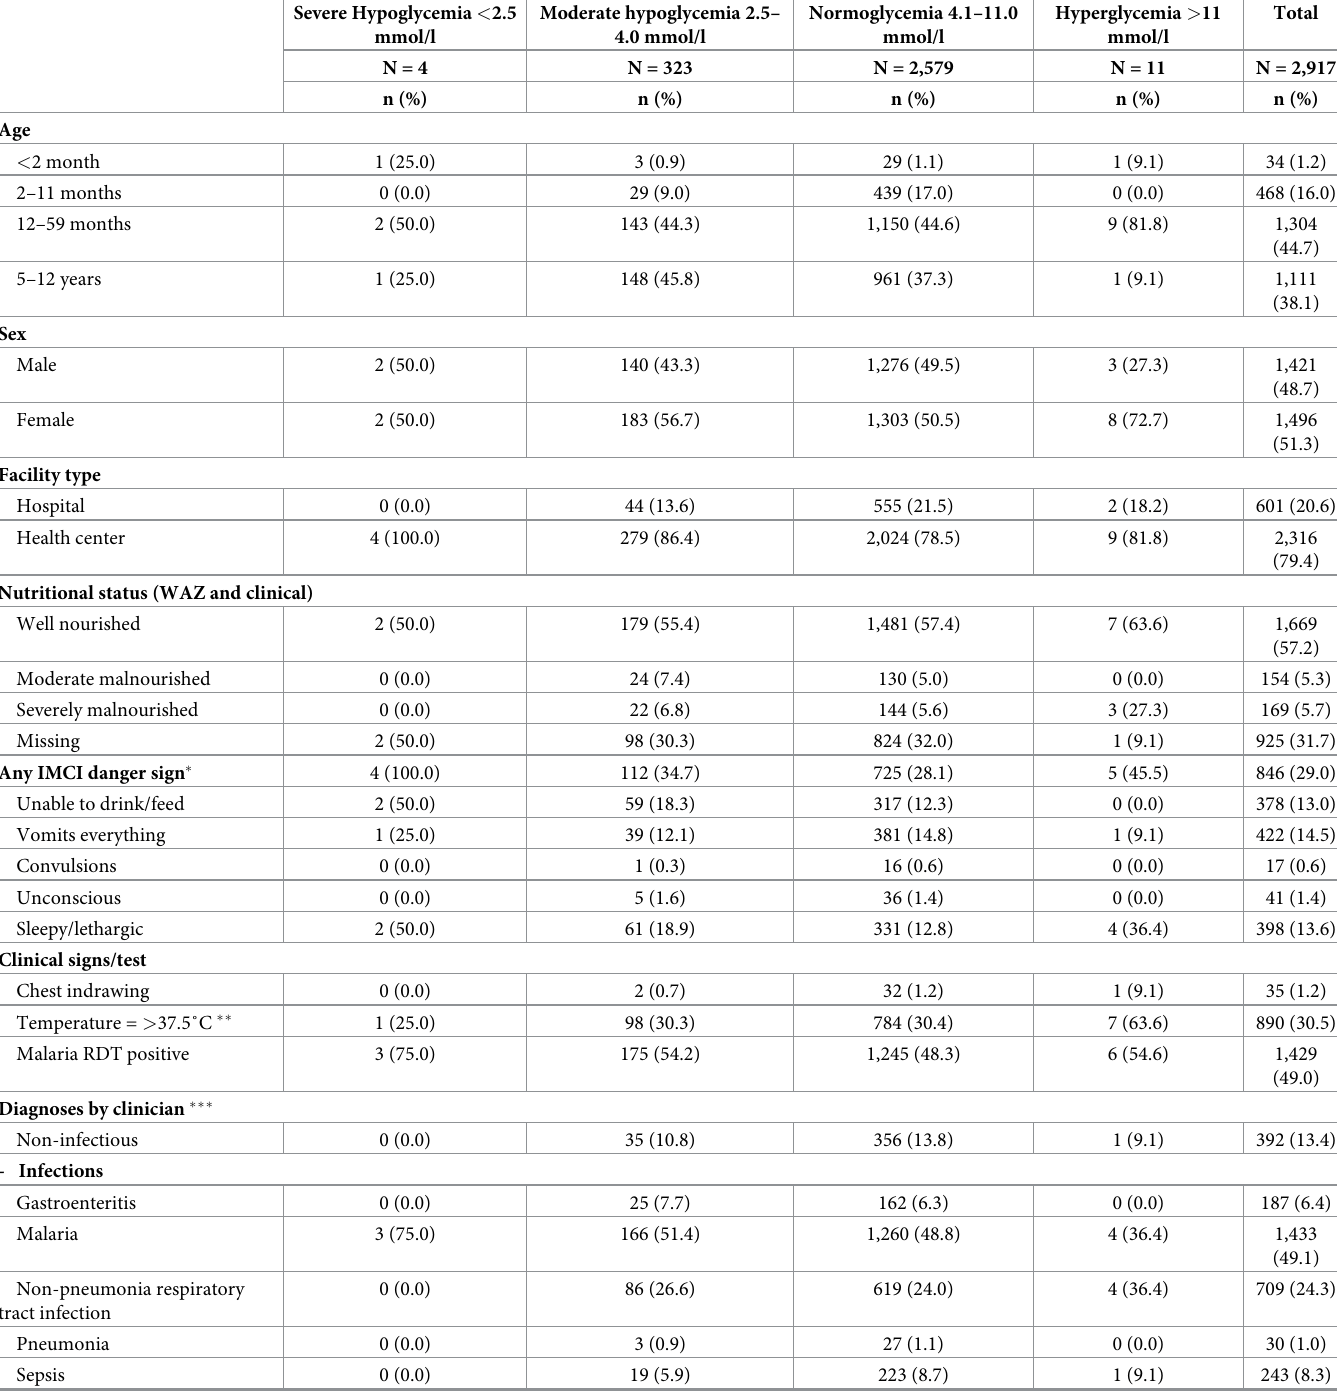
Table 2. Prevalence of different blood glucose concentrations by background and clinical